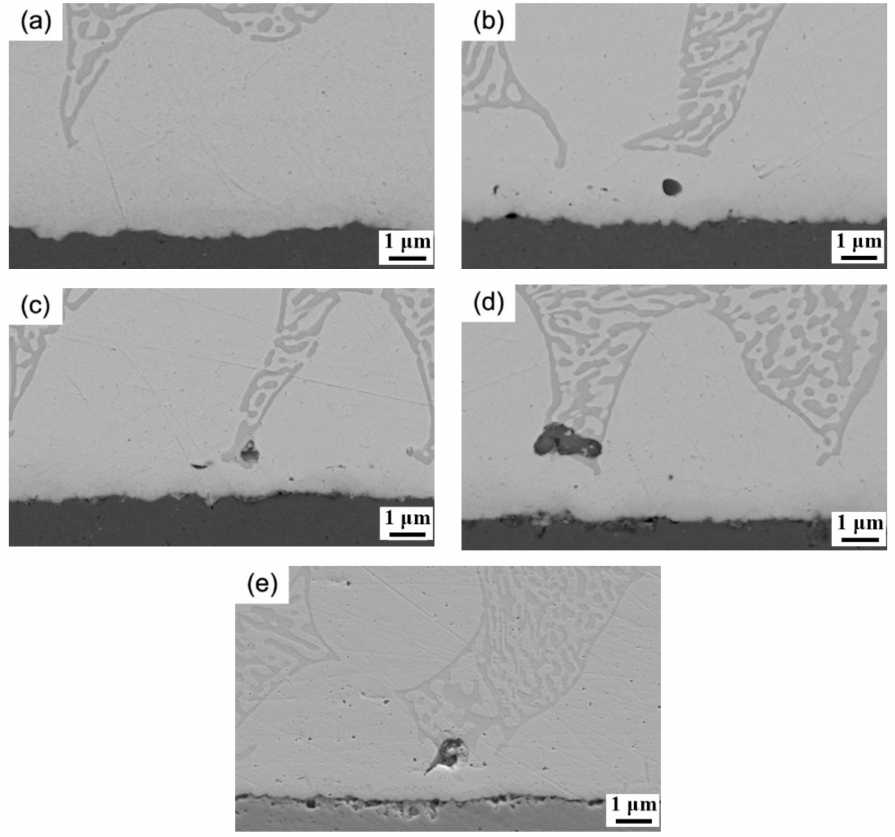
Figure 3. Morphologies of the Au-Sn/Cu joint interfaces soldered by Au-20Sn solders with the oxygen content of: ( a ) 18 ppm, ( b ) 27 ppm, ( c ) 40 ppm, ( d ) 53 ppm, ( e ) 77